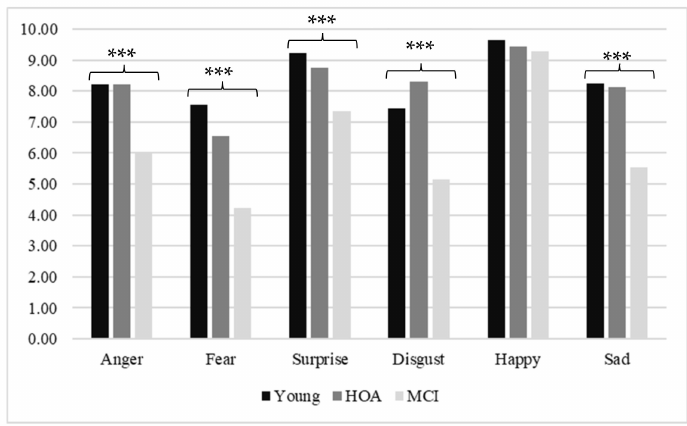
Figure 1. Means of emotions by group. The graph displays inter-subject effects, which revealed differences between groups in recognition of anger *** ( p < 0.001), fear *** ( p < 0.001), surprise *** ( p < 0.001), disgust *** ( p < 0.001), and sad *** ( p < 0.001)